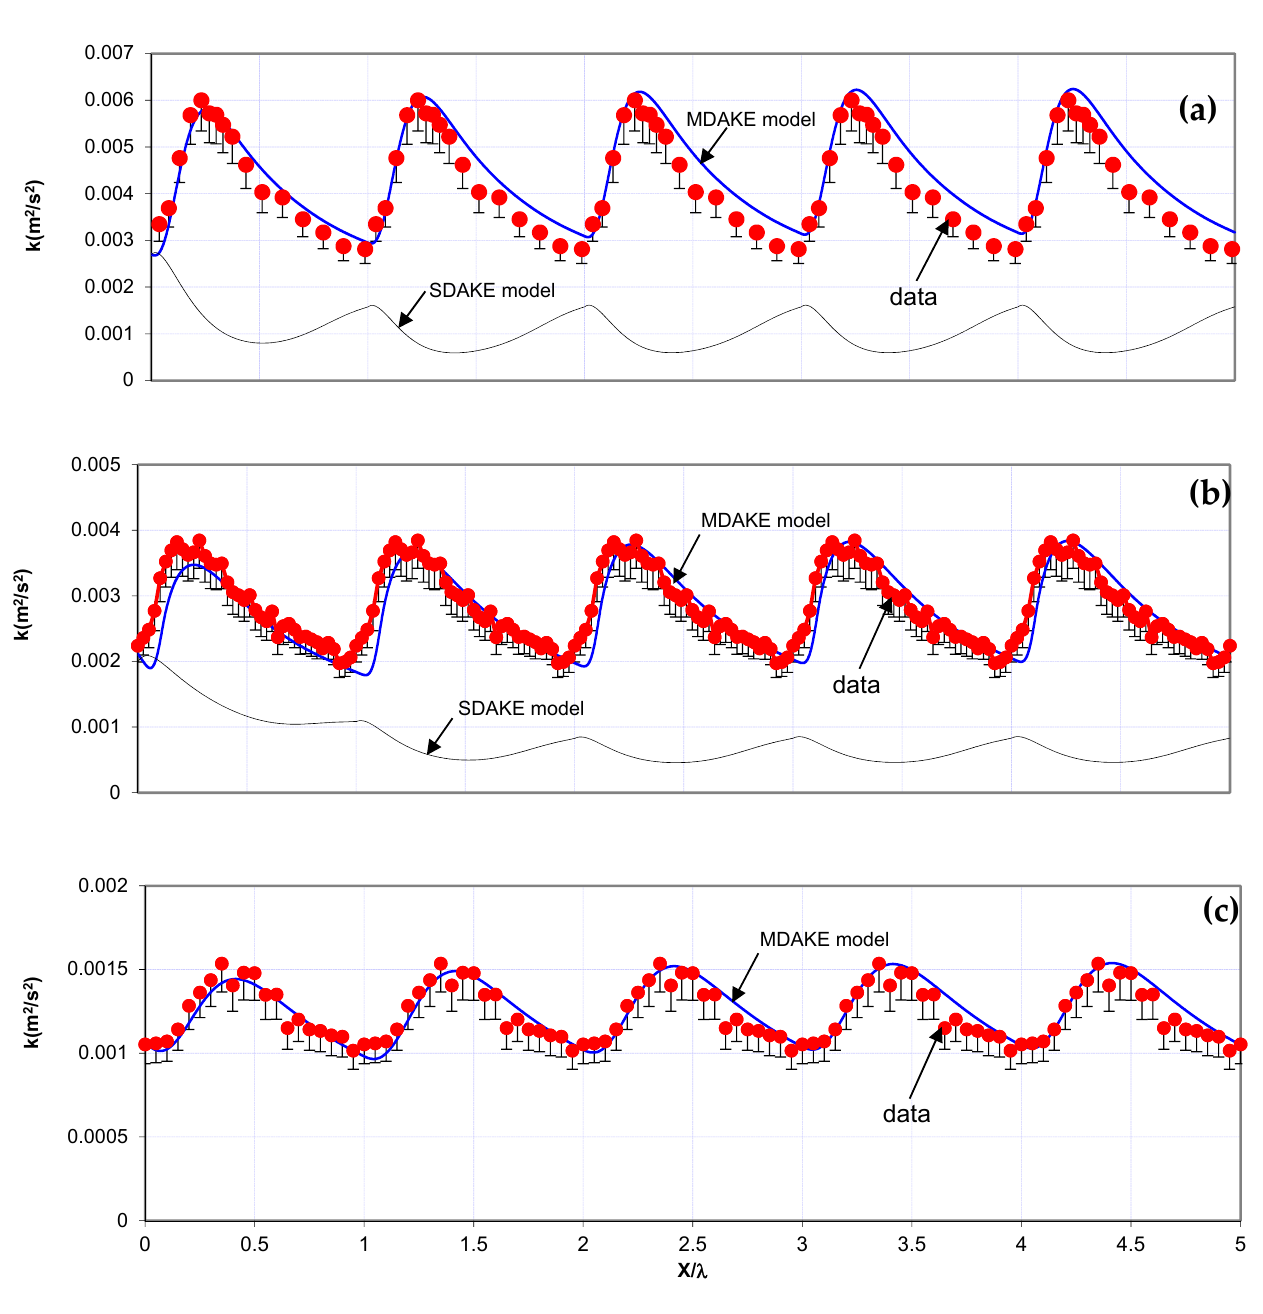
Figure 6. Spatial variation in the depth-averaged turbulent kinetic energy over a train of 5 bedforms for fully developed turbulent flow for: ( a ) experiment (T5), ( b ) experiment (Run2), ( c ) experiment (Run5).